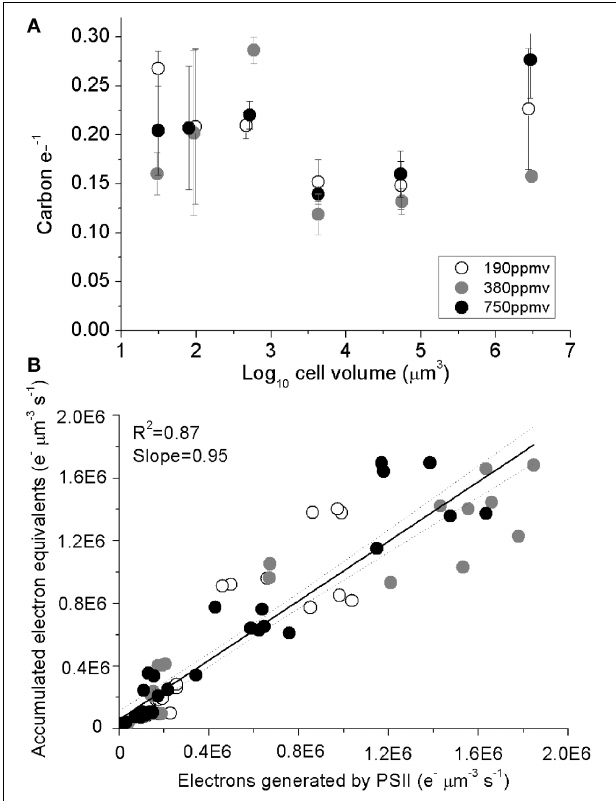
FIGURE 5 | (A) Assimilated C per electron generated by PSII plotted plotted vs. log 10 cell volume; vertical error bars indicate standard deviation. (B) Accumulated electron equivalents vs. electrons generated by PSII. Solid line indicates pooled linear regression for samples from the three p CO 2 levels. Dotted lines indicate the 95% confidence band on the regression. Cultures were grown under p CO 2 190ppmv (open symbols); 380ppmv (shaded symbols) or 750ppmv (black symbols). n =